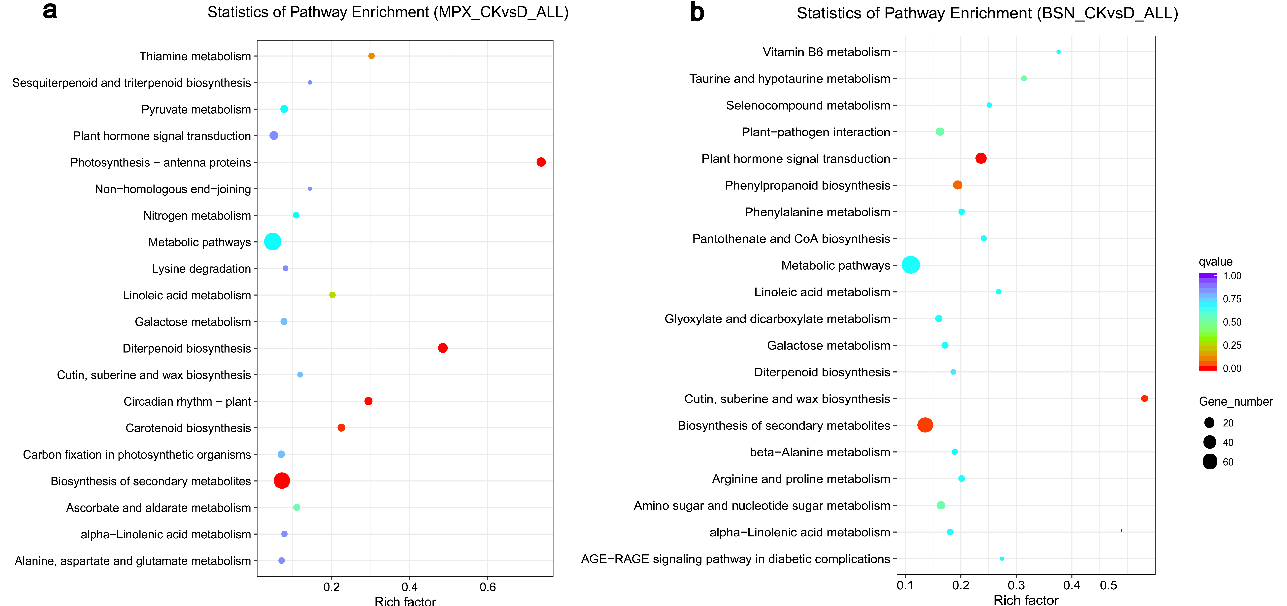
Figure 5. KEGG enrichment of the differential genes. The color and size of the points in the figure indicate the q -value range and the number of differentially expressed genes. The closer the q -value is to zero, the more significant the degree of enrichment. Rich factor refers to the differential expression enriched in the pathway. The ratio of the number of genes to the number of annotated genes is proportional to the degree of enrichment. ( a ) KEGG enrichment of differential genes in the MPX treatment group and the control after 21 days of drought. ( b ) Similar to panel ( a ) but of the